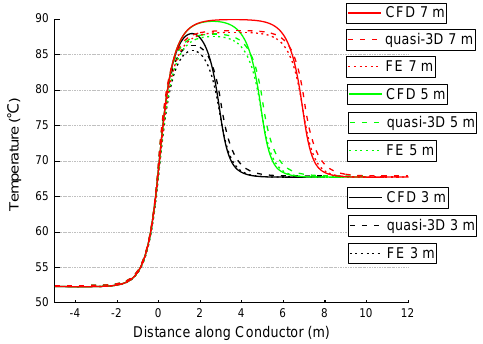
Figure 4. Temperature profiles for different three-dimensional (3D) methods.